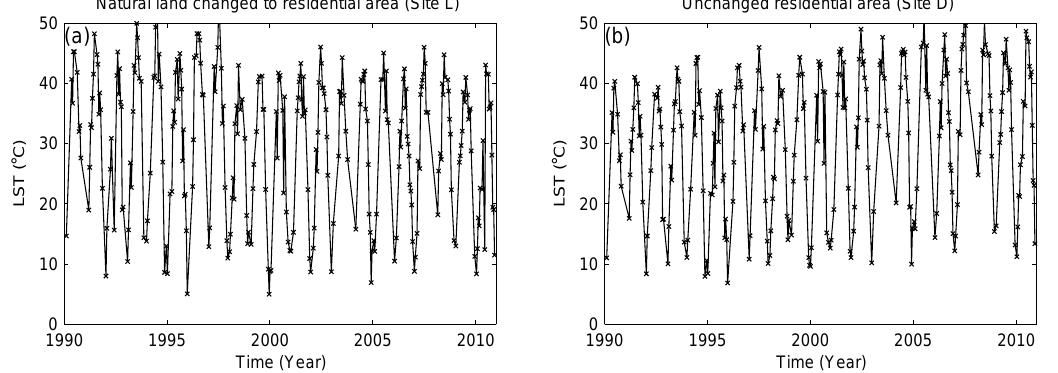
Figure 10. Time series of temperature at selected sites L and D .